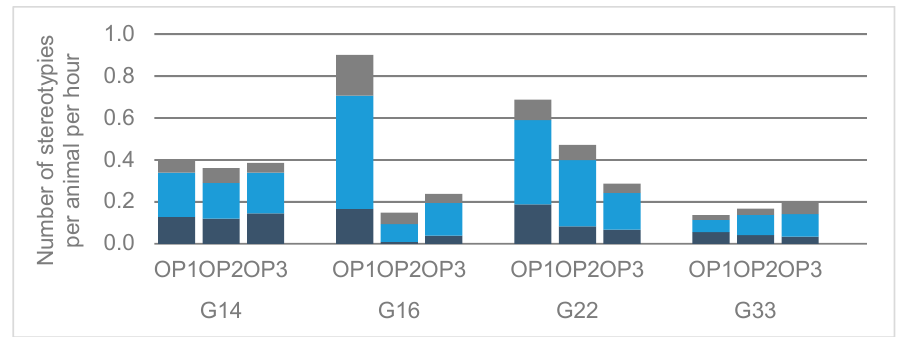
Figure 2. Averaged number of stereotypies observed per animal and hour in different housing systems and observation periods (OP). OP1 = First OP (age of the animals: Eight to nine months), OP2 = second OP (13 to 14 months of age), OP3 = third OP (17 months of age), G14 = groups of 14 animals, G16 = groups of 16 animals, G22 = groups of 22 animals, G33 = groups of 33 animals. Dark blue = tongue playing, light blue = manipulating objects, gray = manipulating conspecifics.